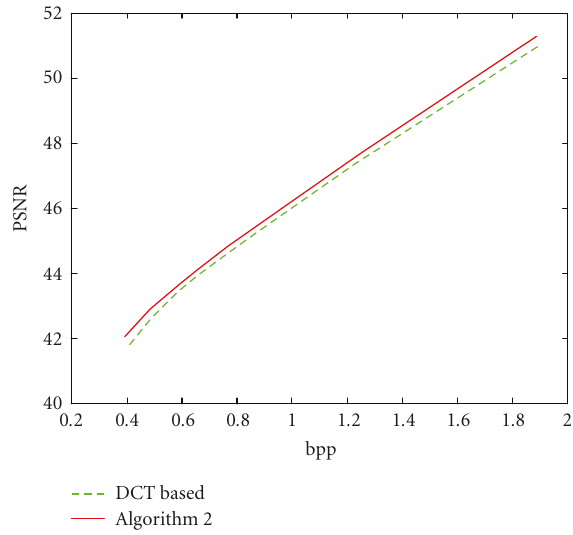
(a) Kidney image: Algorithm 2 versus DCT-based compression